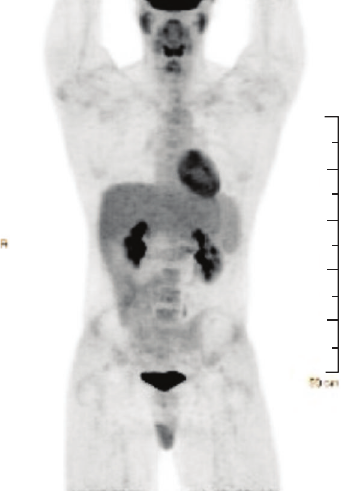
Figure 4: Pretreatment maximum intensity projection (MIP) scan of the whole body showed increased extensive lymphadenopathy above and below the diaphragm with multiple osseous foci of increased FDG uptake. Table 2: Patient’s lab values following six cycles of ABVD chemo- therapy.